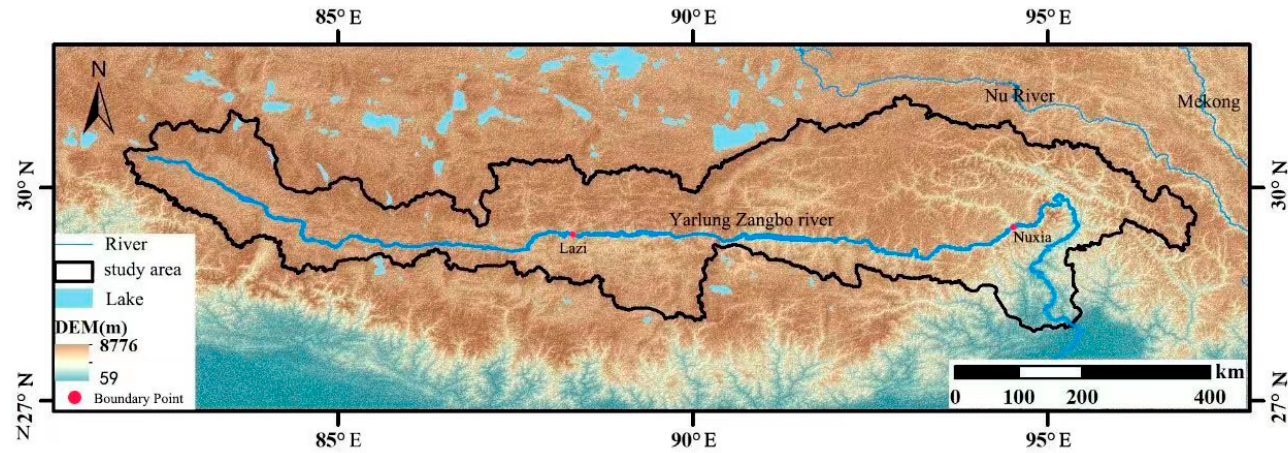
Figure 1. Overview of the study area.